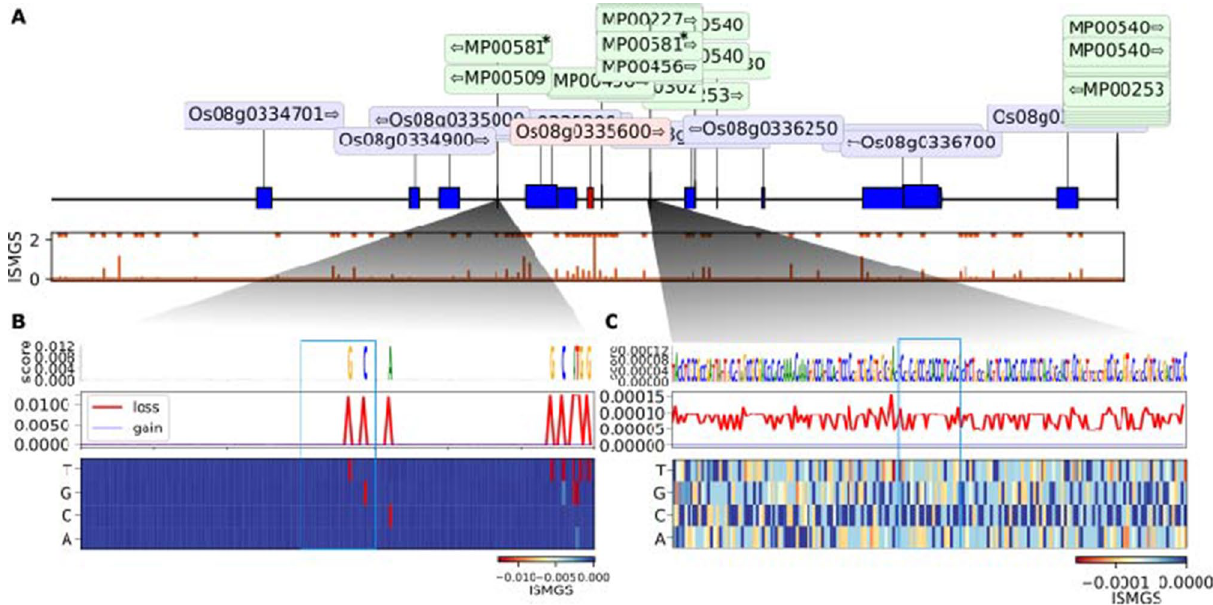
Figure 6. In silico mutagenesis of OSAIR12 . ( A ) (top panel) A 200 kb neighboring window around trans - regulatory target gene “ OSAIR12 ” (red). All the other genes are marked in blue and transcription factors (TFs) in green. The predicted mutagenesis score and its significant peaks is shown in the panel below. ( B , C ) Mutagenesis of every base within two cis regions to other possibilities and their effect on the TSS of OSAIR12 . The locations of TF MP00581 are marked with blue